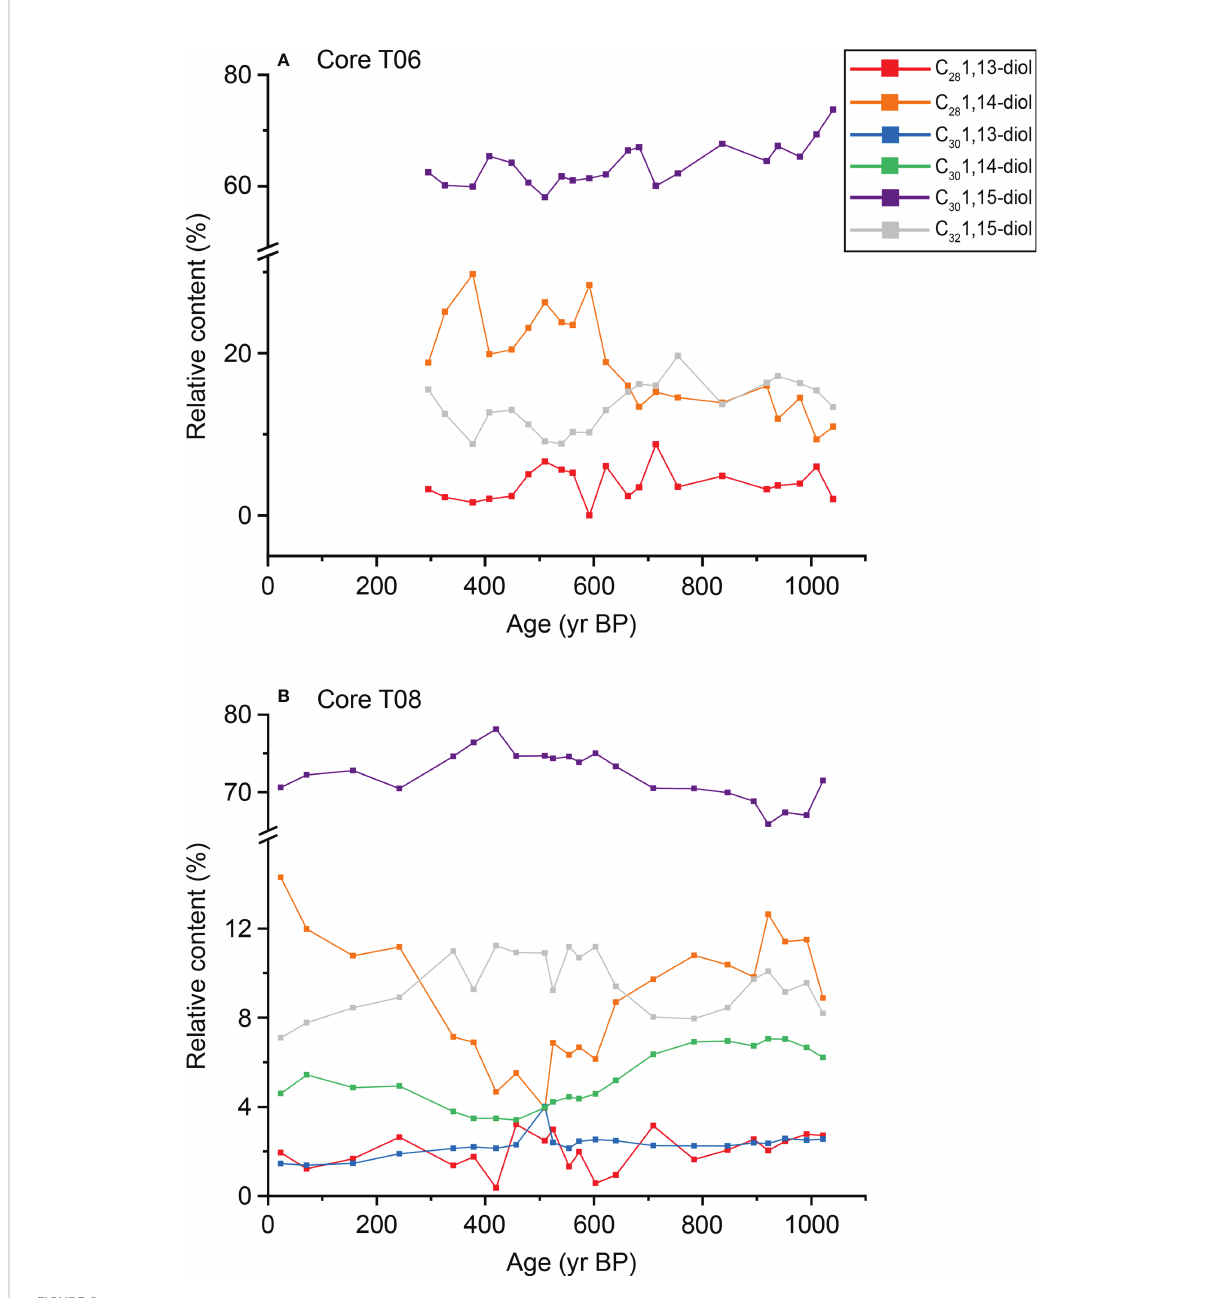
FIGURE 2 Downcore variations in the relative contents of various diols species in sediment samples from (A) core T06 and (B) core T08. The contents of C 30 1,13-diol and C 30 1,14-diol are below the detection limit in core